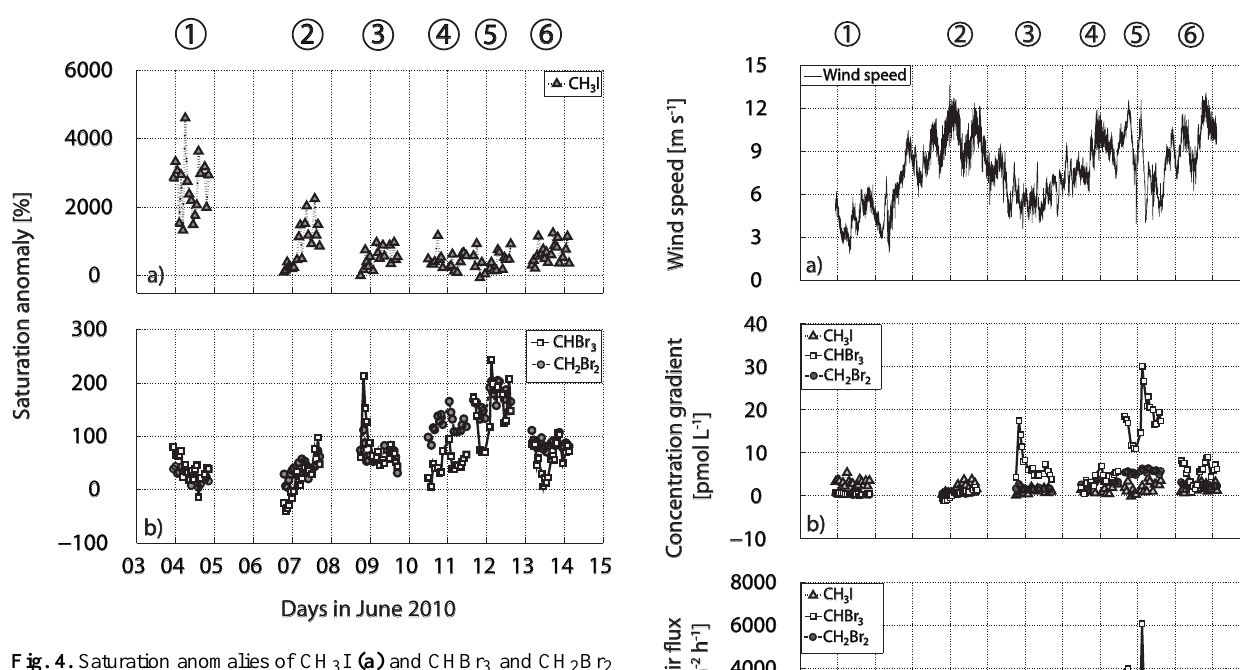
Fig. 4. Saturation anomalies of CH 3 I (a) and CHBr 3 and CH 2 Br 2 (b) throughout the RV Poseidon cruise.